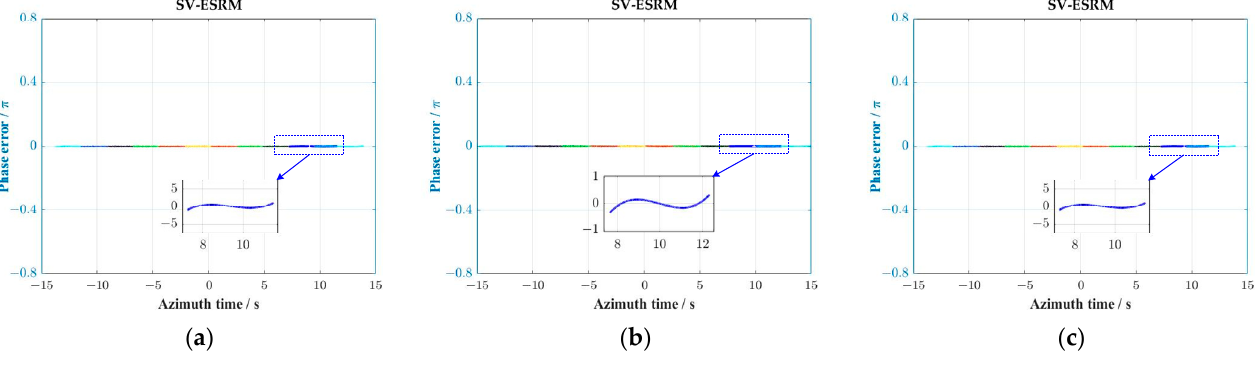
Figure 5. The phase error as a function of azimuth time caused by MESRM. ( a – c ) represent the errors along azimuth direction in the near, central, and far range cells, respectively. Lines with different colors represent the errors of different targets with a constant interval of 2 km along azimuth direction.